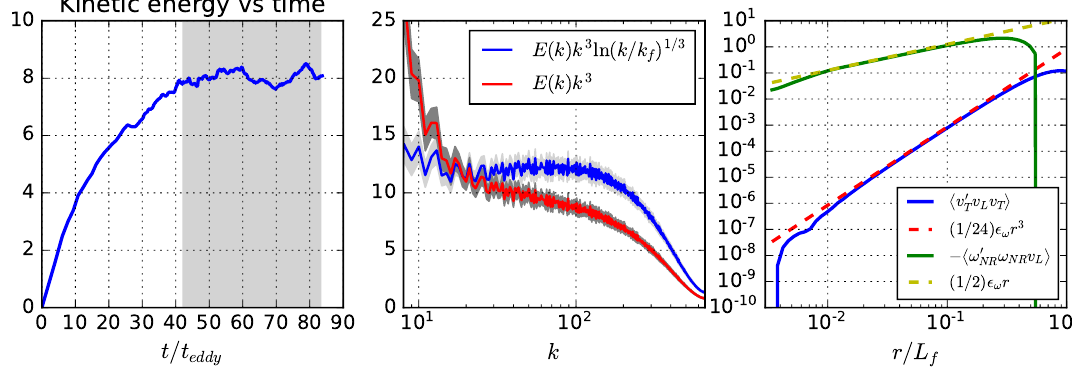
Figure 9 . Data from our simulation of an incompressible Navier-Stokes (cid:13)uid. (Left): the average speci(cid:12)c Newtonian kinetic energy plotted as a function of time. The shaded interval corresponds to the interval over which we compute statistical averages. (Centre): the energy spectrum E ( k ) compensated by either k 3 ln k=k f 1 = 3 or k 3 . The shaded envelopes correspond to 5 (cid:2) the statistical p error (cid:27)= N . The logarithmic correction is evidently favoured. (Right): the correlation functions (solid) and their predictions (dashed) corresponding to the incompressible counterparts of eqs. (2.8) and